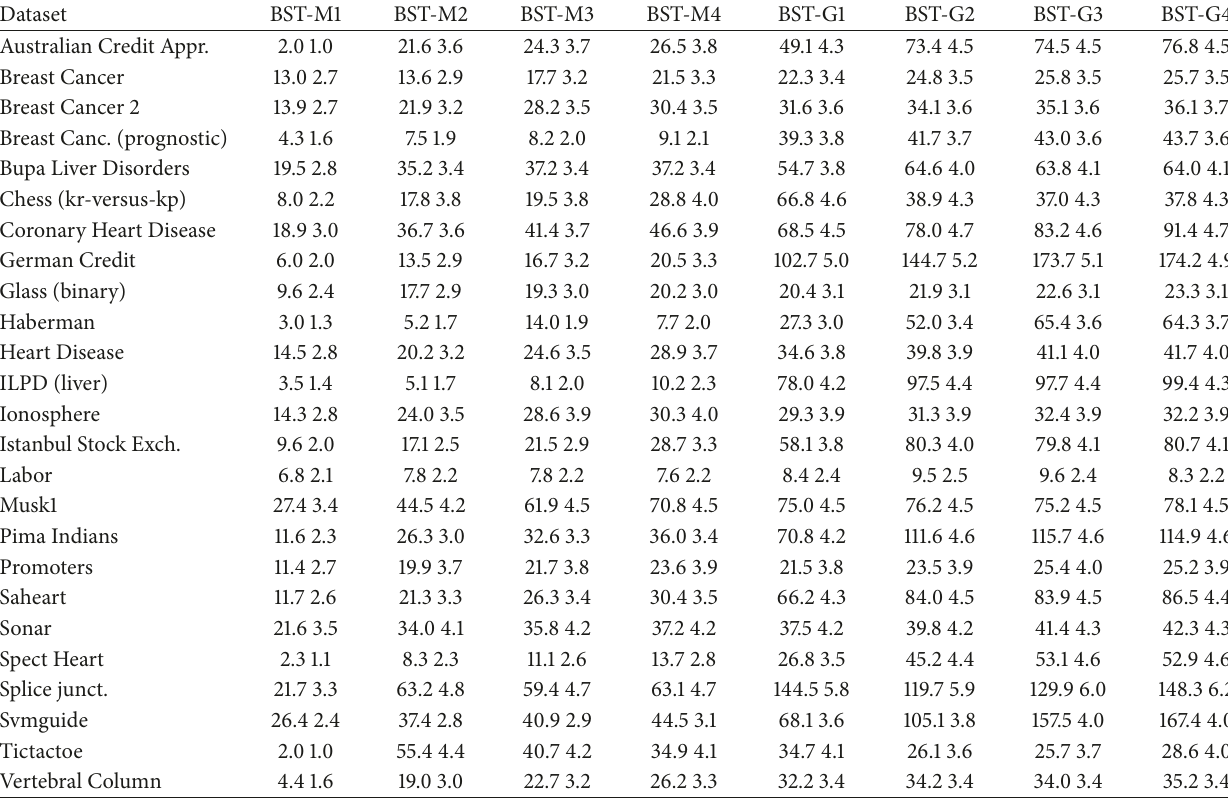
Table 6: Average complexity of the extracted rules given by the number of rules and antecedents per rule for BST-M and BST-G. Dataset Australian Credit Appr.